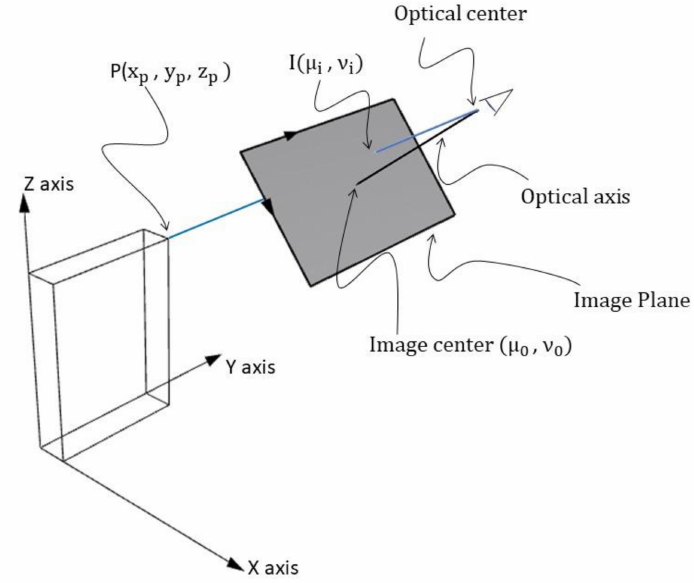
Figure 1. Graphical representation: a 3D world point P is projected onto a 2D image plane on point I. (Source: Personal collection, adapted from